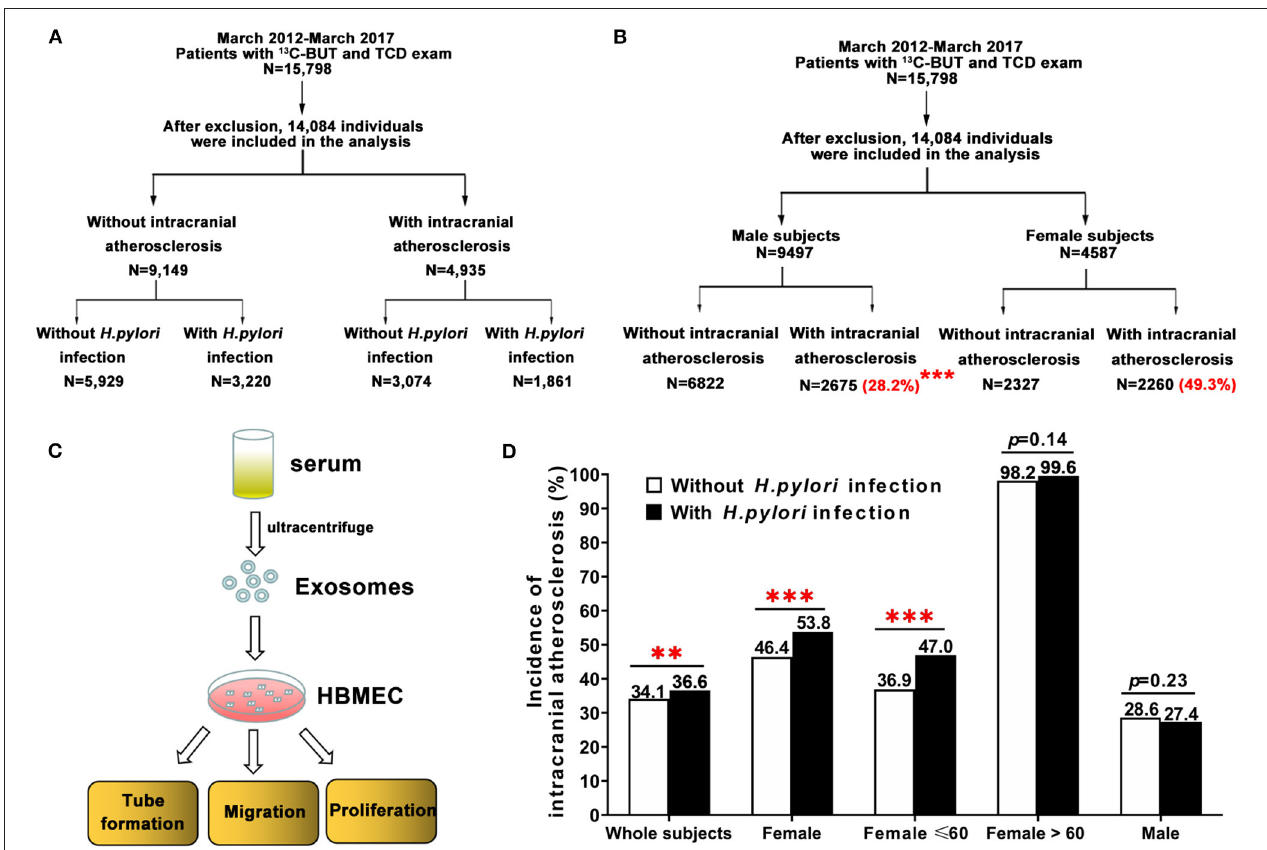
FIGURE 1 | Study design and the incidence of intracranial atherosclerosis among individuals with and without H. pylori infection, stratified by age. (A,B) Subjects were screened and divided into different groups based on the study protocol. (B) Female subjects had a significantly higher prevalence of intracranial atherosclerosis than men (49.3 vs. 28.2%, *** p < 0.001). (C) To test the role of H. pylori on endothelial cell function, serum exosomes obtained from human subjects by ultracentrifugation were added to HBMEC to assess migration, tube formation, and proliferation. (D) There was a significant difference in the incidence of intracranial atherosclerosis between subjects with and without H. pylori infection (36.6 vs. 34.1%, ** p < 0.01). H. pylori -positive women had a significantly higher incidence of intracranial atherosclerosis than H. pylori -negative women (53.8 vs. 46.4%, *** p < 0.001). Further analysis showed age differences in H. pylori -infected women and incidence of intracranial atherosclerosis. However, there was no significant difference in intracranial atherosclerosis incidence between male subjects with and without H. pylori infection. HBMEC, human brain microvascular endothelial cells.